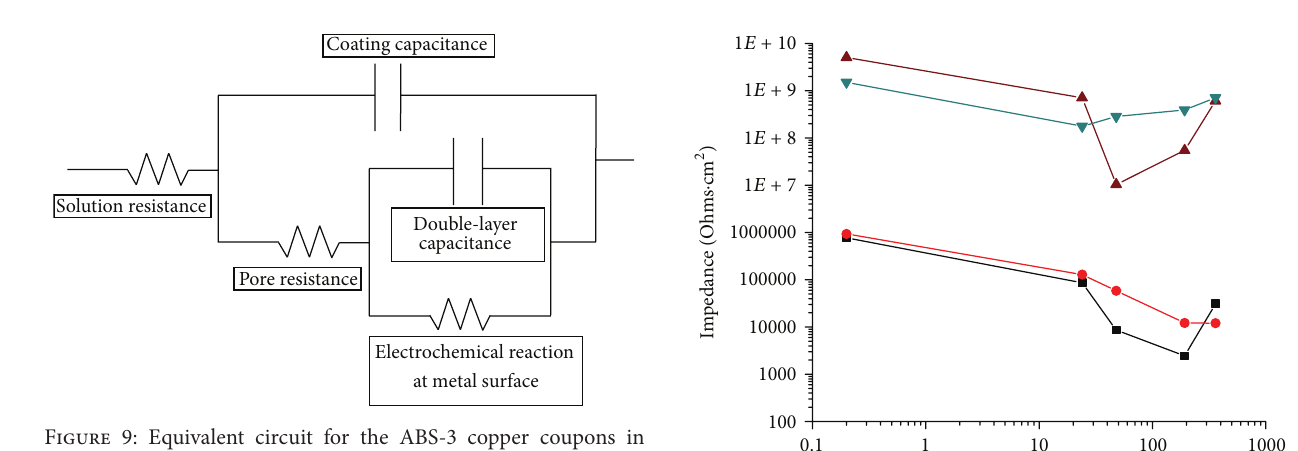
Figure 9: Equivalent circuit for the ABS-3 copper coupons in Na 2 SO 4 + 3 wt% NaCl solution obtained by the electrochemical impedance technique.